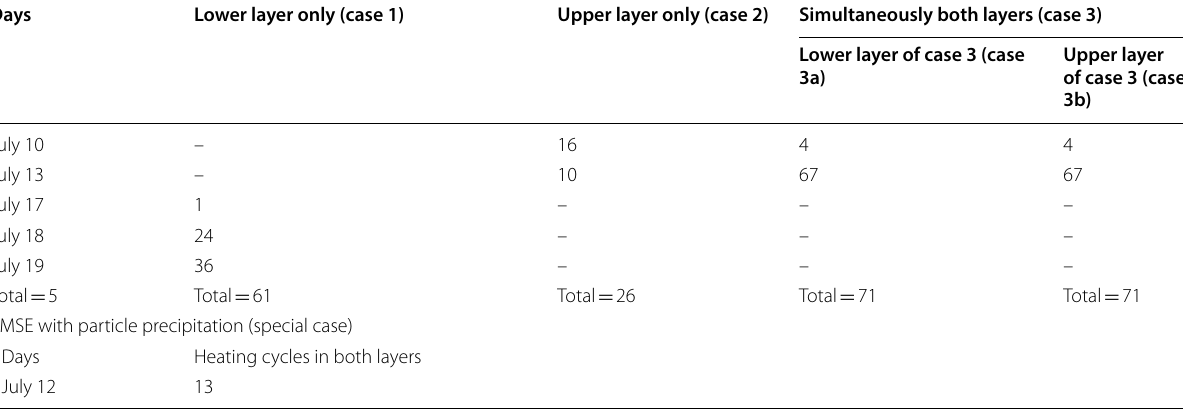
Table 1 Heating cycles having PMSE with no particle precipitation in July